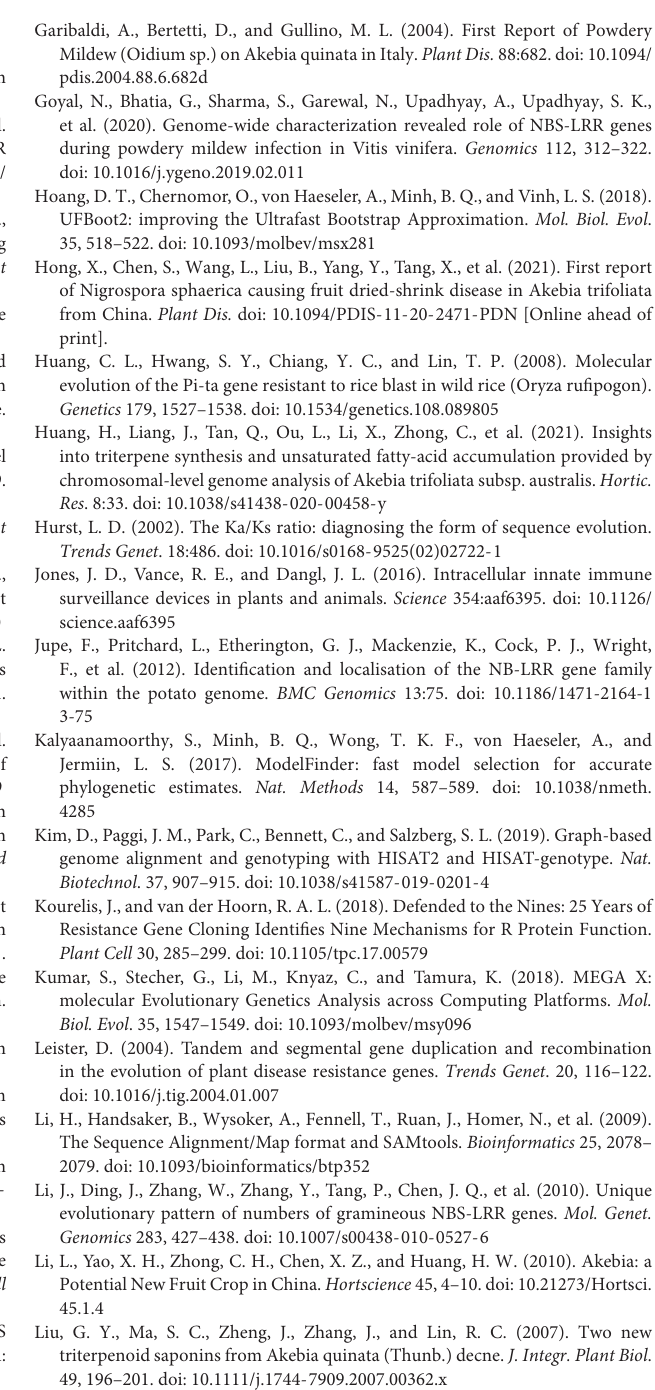
Supplementary Table 4 | Reference NBS genes identified from other species for reconstructed phylogenetic trees. Supplementary Table 5 | Ka Ks and Ka/Ks values of A. trifoliata NBS gene pairs. Supplementary Table 6 | NBS genes Expression profile of the three A. trifoliata tissues and four development stages. Supplementary Table 7 | TNLs and CNLs for both exon number and gene length in 7